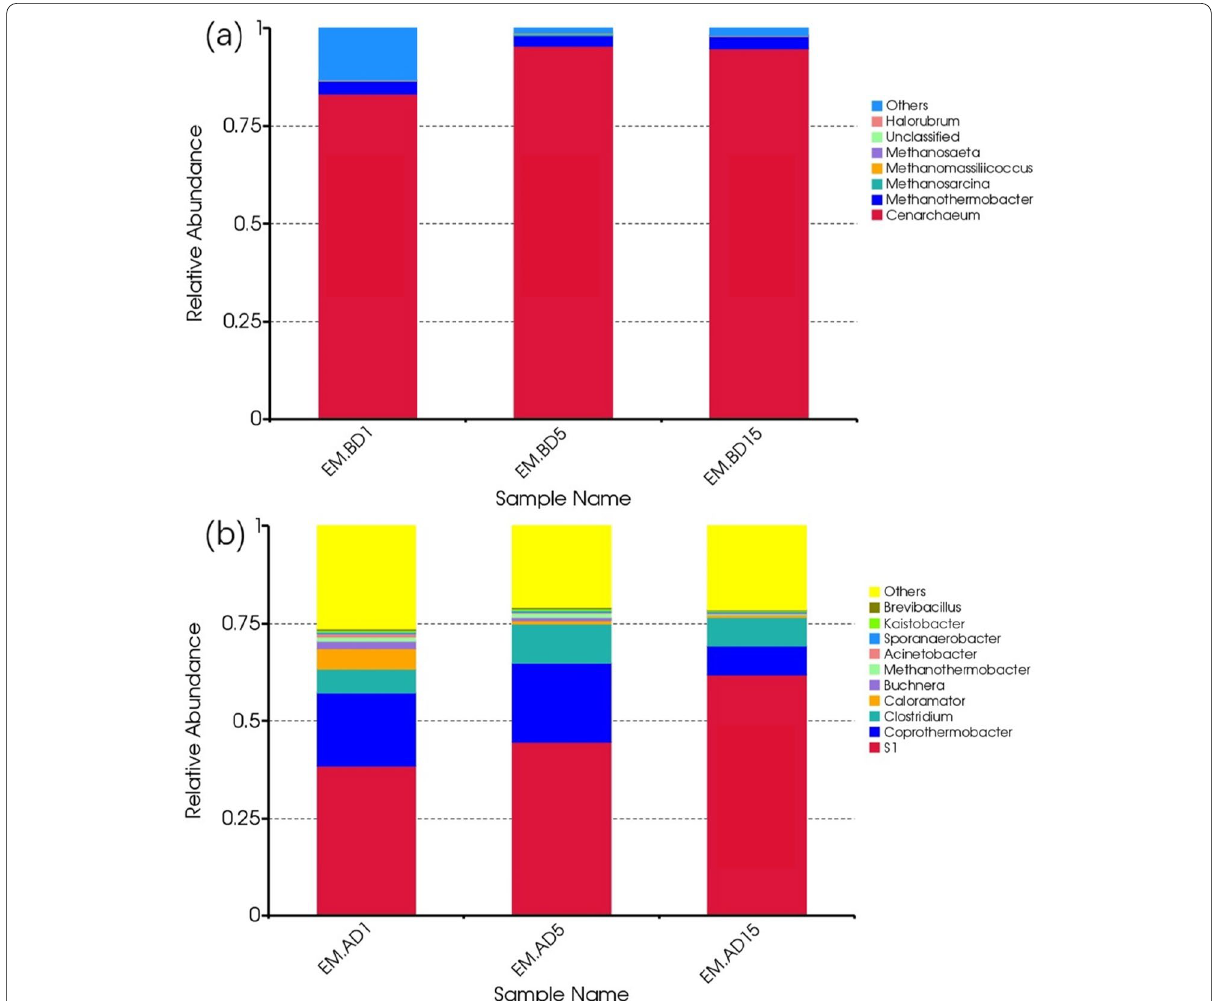
Fig. 3 The relative abundance histogram of sequencing results in E. prolifera fermentation flora. EM-Da means the archaea of EM-D, EM-Db means the bacteria of EM-D, the number of the sample name means the acquisition time in